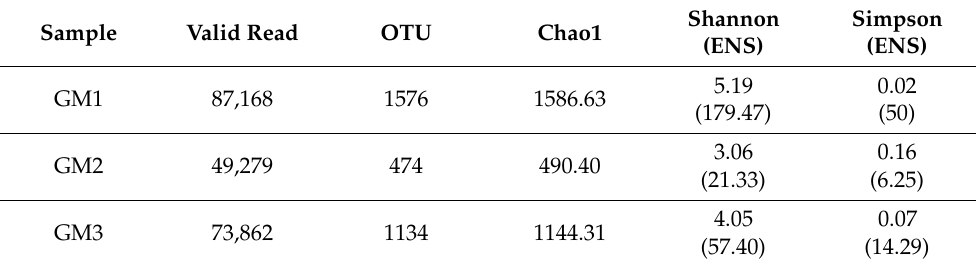
Table 3. Alpha diversity indices, i.e., Chao1, Shannon, and Simpson indices, for the OTUs for